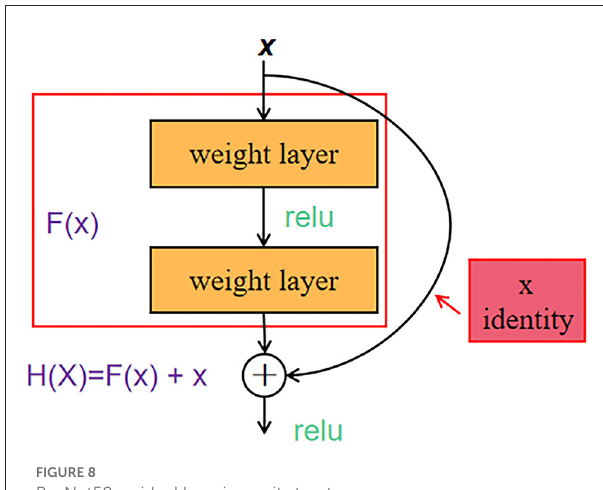
FIGURE8 ResNet50 residual learning unit structure.